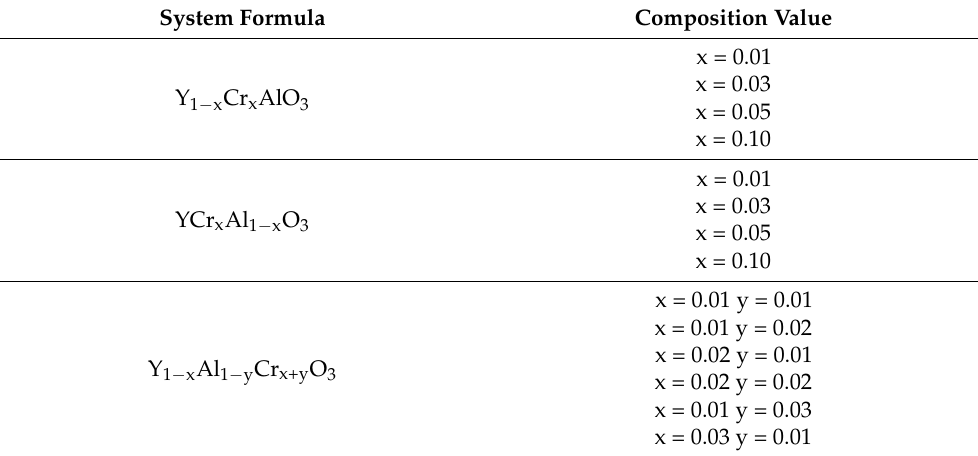
Table 1. Nominal compositions prepared.